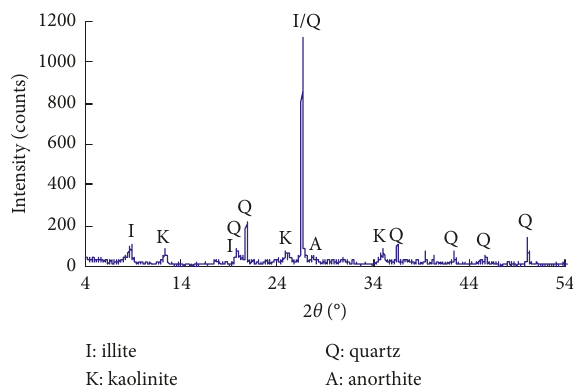
Figure 1: Representative X-ray diffraction pattern of a